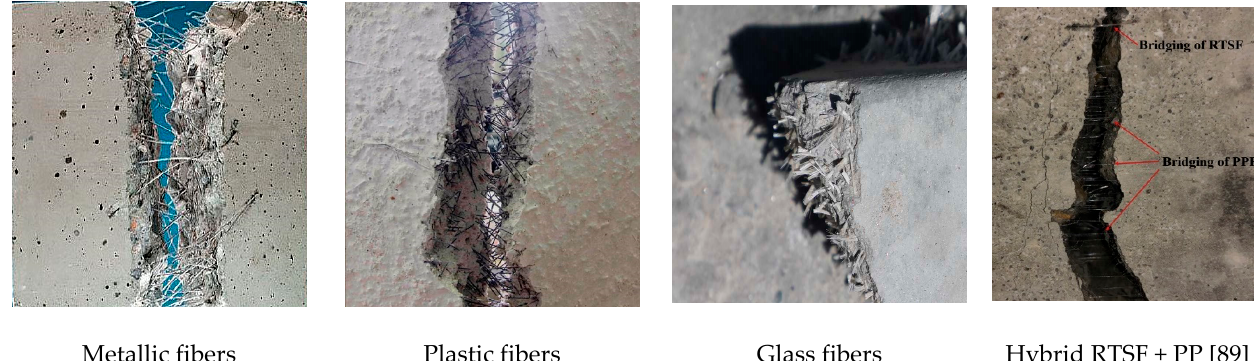
Figure 4. Cement based elements reinforced with recycled fibers used in R-FRC applications .